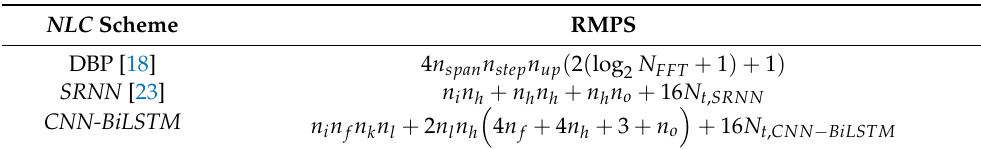
Table 1. Complexity analysis results of different schemes.